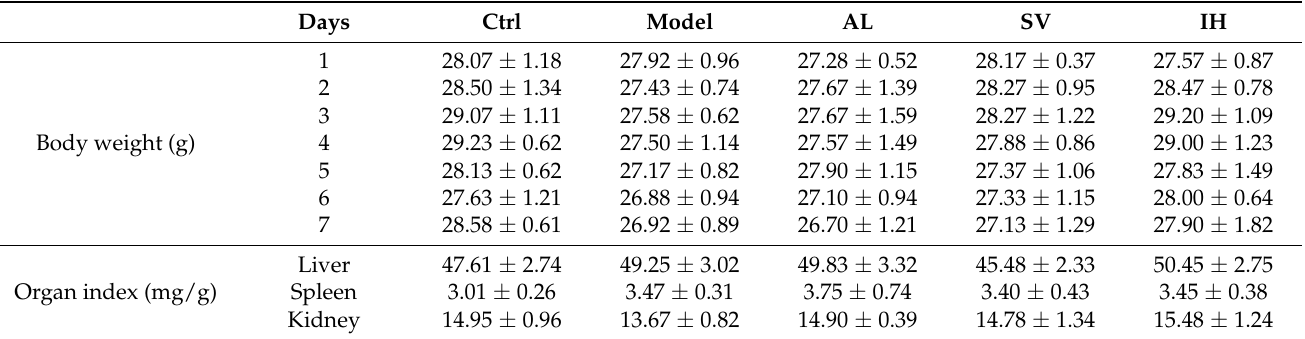
Figure 1. SV and IH relief symptoms on YEP/OXO-induced hyperuricemia in mice. ( A ) Schematic diagram of the experimental schedule performed in the mice with hyperuricemia. In the YEP/OXO-induced mice with hyperuricemia, SV and IH reduced the high serum levels of UA ( B ) and XOD ( C ) and suppressed the levels of XOD ( D ) in the liver. ( E , F ) SV and IH reduced the expressions of XOD in the liver of mice with hyperuricemia. Data are shown as means ± SD ( n = 6 mice/group). # p < 0.05, ## p < 0.01 vs. Ctrl group, * p < 0.05, ** p < 0.01, *** p < 0.001 vs. model group. Table 1. Effects of SV and IH on body weight and indices of the liver, spleen, and kidney in mice with hyperuricemia.